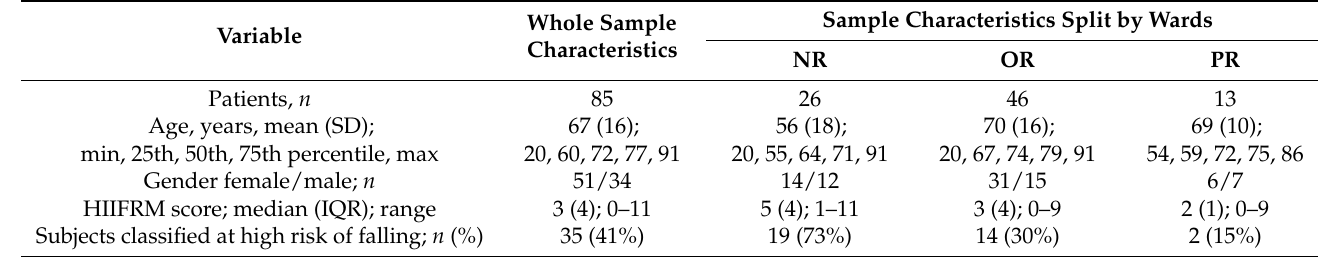
Table 1. Sample characteristics at discharge from rehabilitation wards.